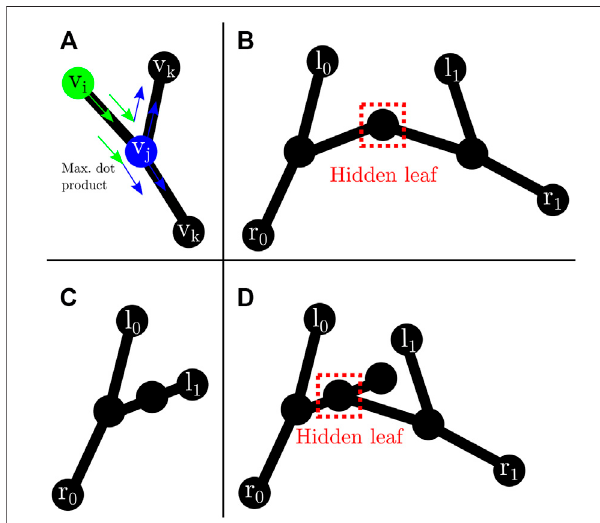
FIGURE 6 | Leaf traversal and hidden leaves: (A) graph traversal step. v i (green) represents the previous node. v j (blue) is the current node. v k are possible next nodes. Following (3), the next node will be the one that maximizes the dot product; (B) possible hidden leaf (dashed red box) connected to two nodes; (C) node with two neighbours that does not represent a hidden leaf as both connecting edges are labelled after dot product traversal from l 1 ; (D) possible hidden leaf (dashed red box) with three neighbours.